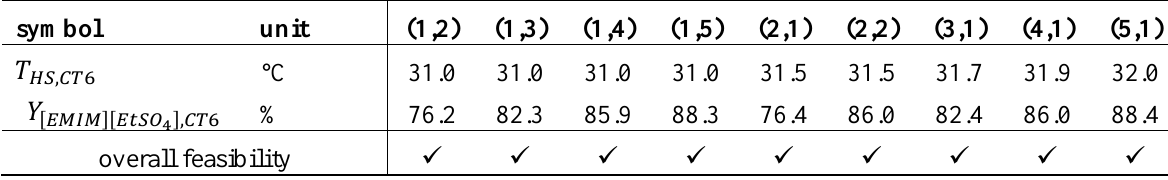
Table 8. Results for CT6 after reactor